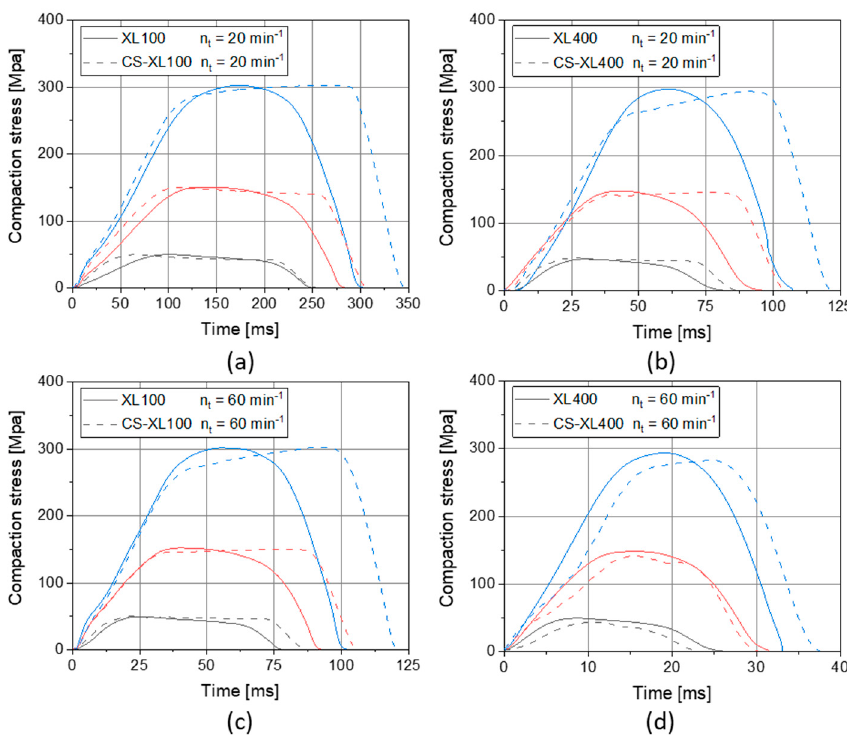
Figure 4. Comparison of compaction profiles of rotary presses and their respective simulation by CS for XL100 at 20 min − 1 ( a ) and at 60 min − 1 ( c ) as well as XL400 at 20 min − 1 ( b ) and at 60 min − 1 ( d ), at different target compaction stress of 50 (black lines), 150 (red lines), and 300 MPa (blue lines), applying 14 mm punches, respectively.